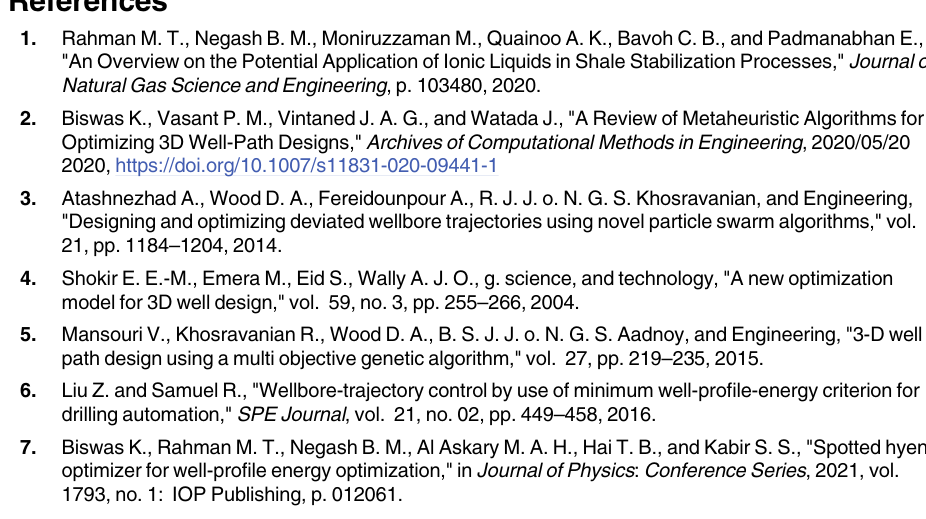
S1 Appendix. Table A1. Description of the